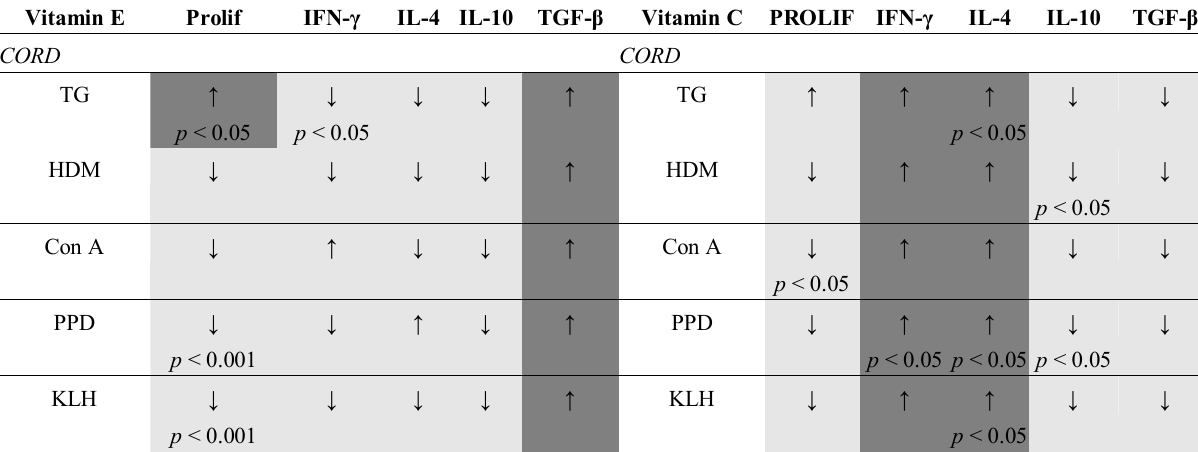
Table 1. Summary table representing the mean responses of CBMC and peripheral blood mononuclear cell (PBMC) samples to control stimuli and allergens, after supplementation with vitamin E or vitamin C. The mean change in response is shown for 70 CBMC samples and 18 PBMC samples, after supplementation with vitamin E, and for 51 CBMC and 18 PBMC samples, after supplementation with vitamin C. Significant p values for differences in responses between paired samples in cultures with or without vitamin E/vitamin C supplementation are shown on the relevant